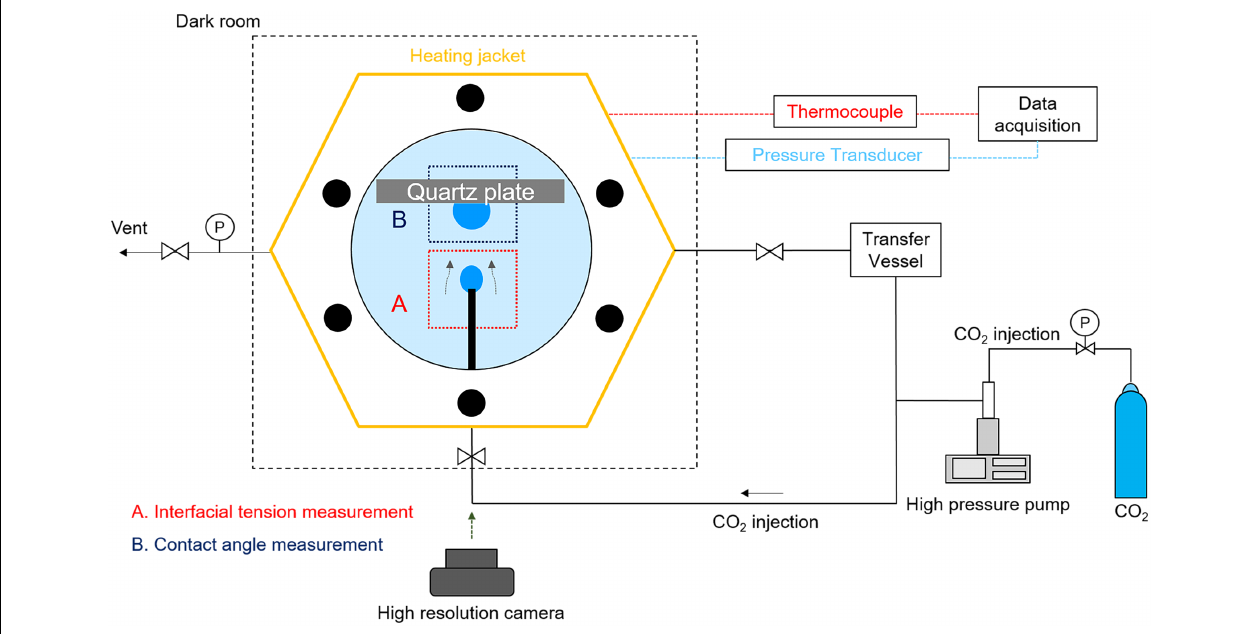
FIGURE 1 | Experimental setup for measuring (A) interfacial tension (IFT) and (B) contact